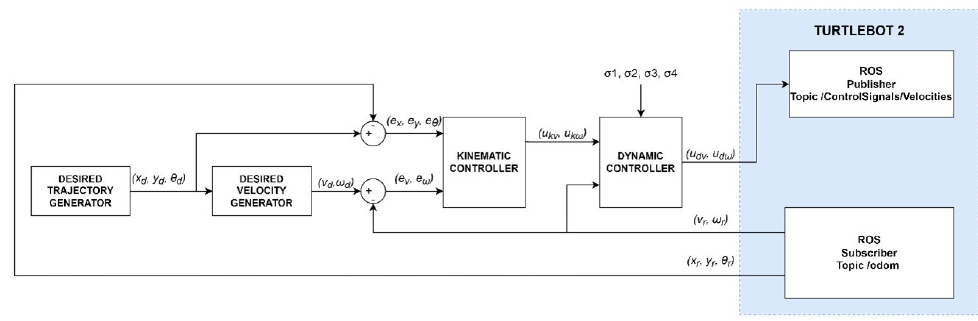
Figure 14. Block diagram of the real TURTLEBOT 2 robot’s tracking motion control system.